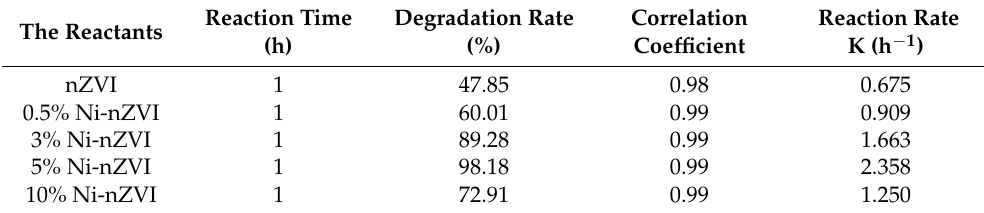
Table 1. Kinetic parameters of TCE degradation.